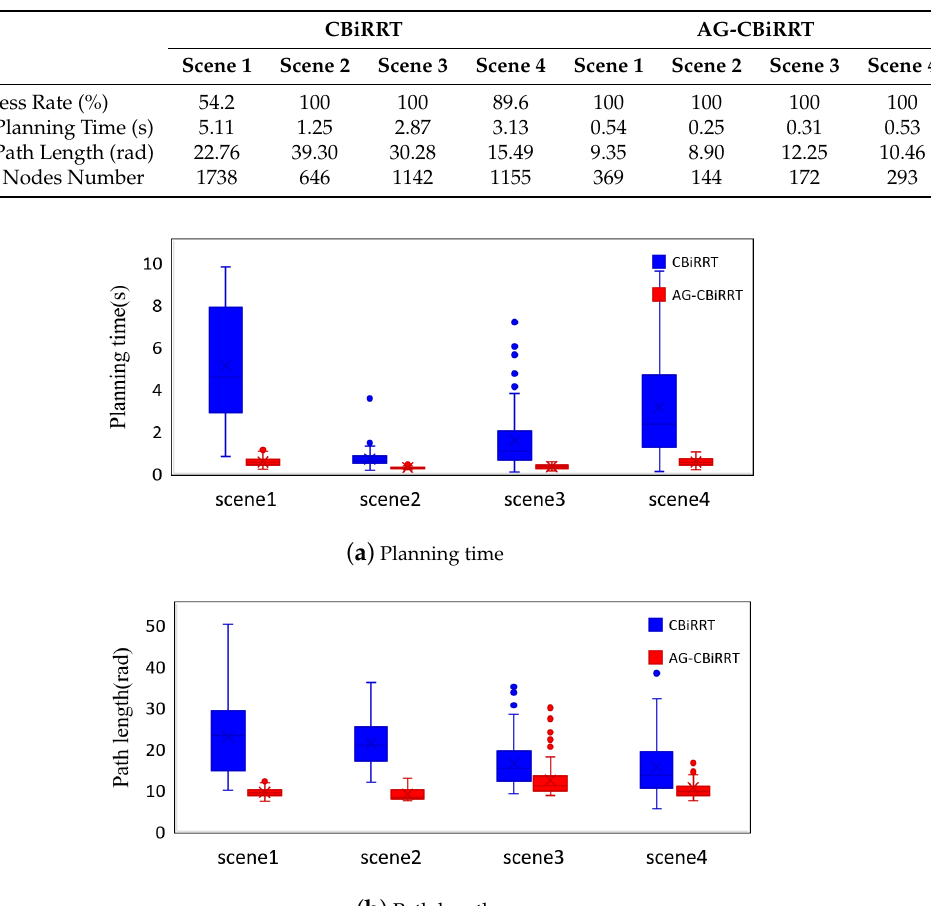
Figure 5. Box-plots of motion planning